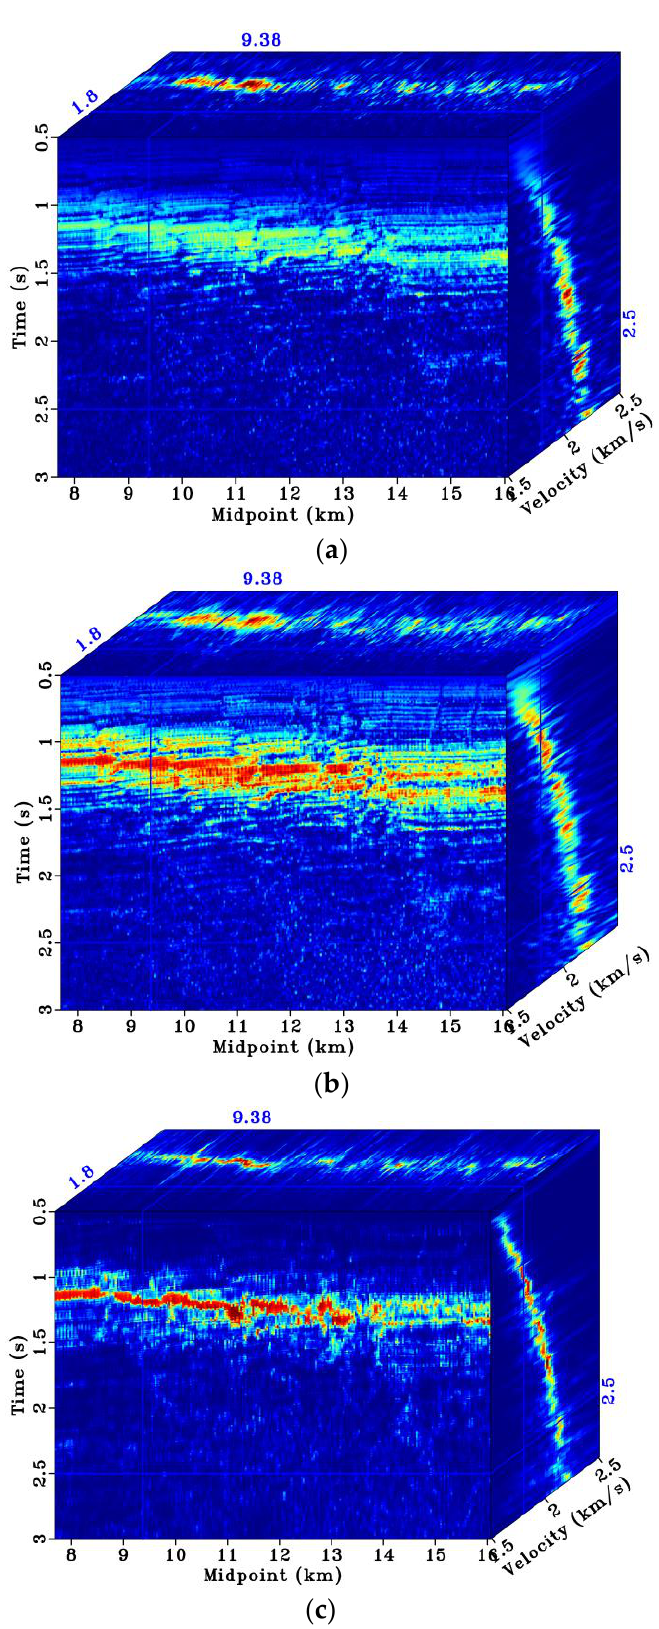
Figure 8. A field data with 250 CMP gathers from the Gulf of Mexico.